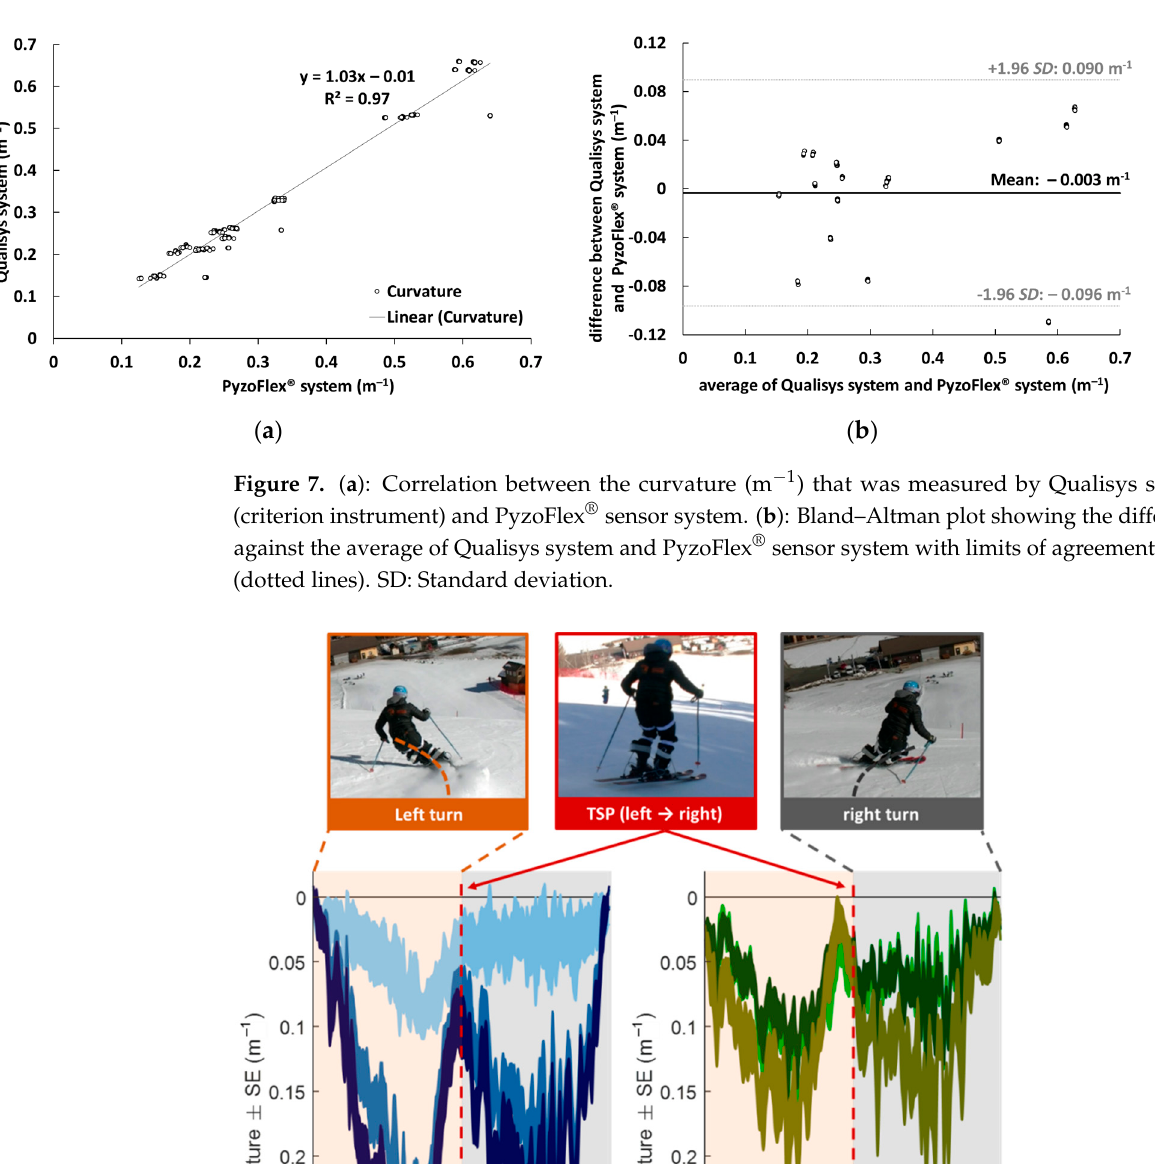
Figure 7. ( a ): Correlation between the curvature (m − 1 ) that was measured by Qualisys system (criterion instrument) and PyzoFlex ® sensor system. ( b ): Bland–Altman plot showing the difference against the average of Qualisys system and PyzoFlex ® sensor system with limits of agreement (LoA) (dotted lines). SD: Standard deviation.